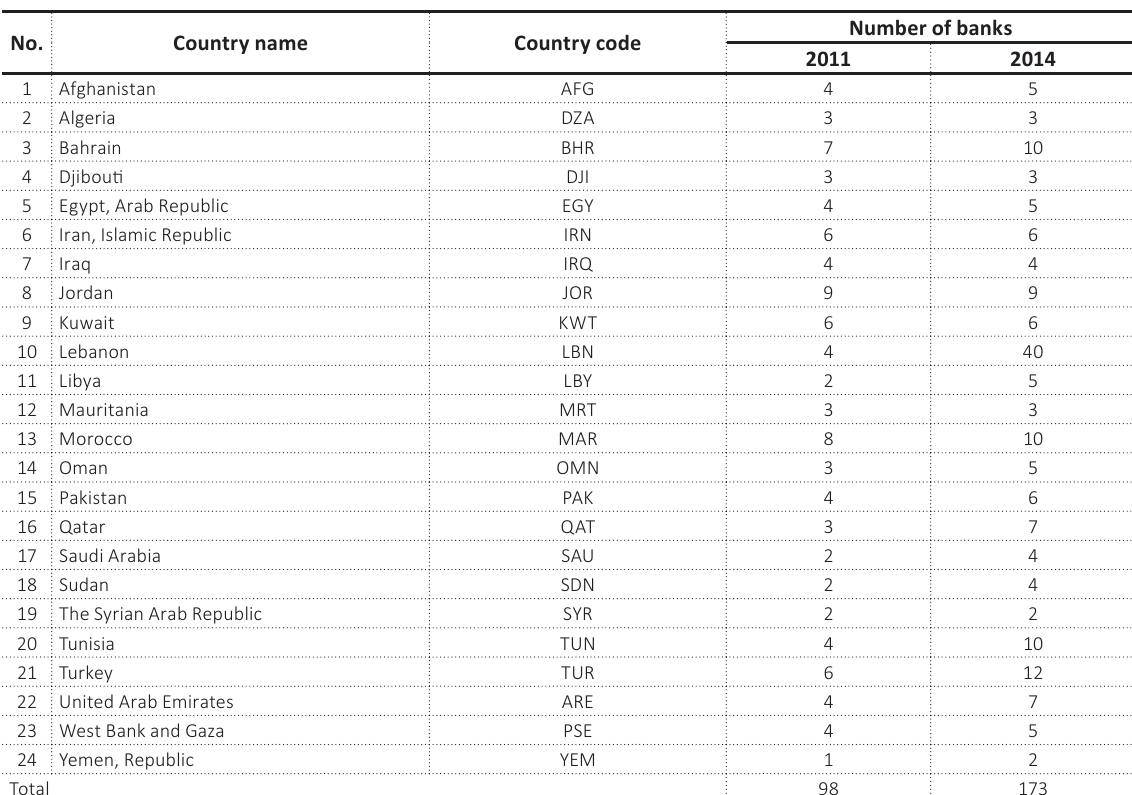
Table A1. Countries and the number of banks